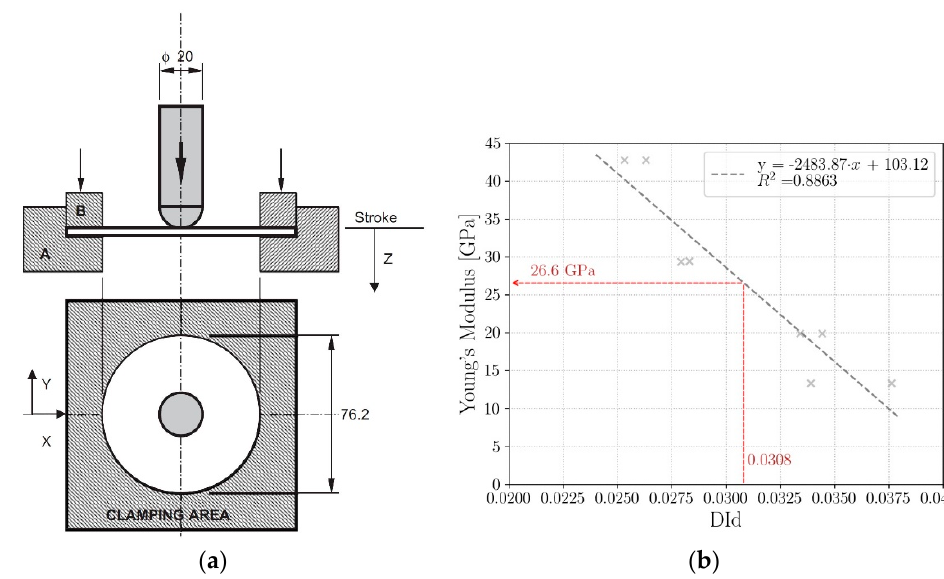
Figure 5. ( a ) Scheme of the testing fixture of the DI d technique [61]; ( b ) relationship between the residual elastic properties and the DI d parameter [64].